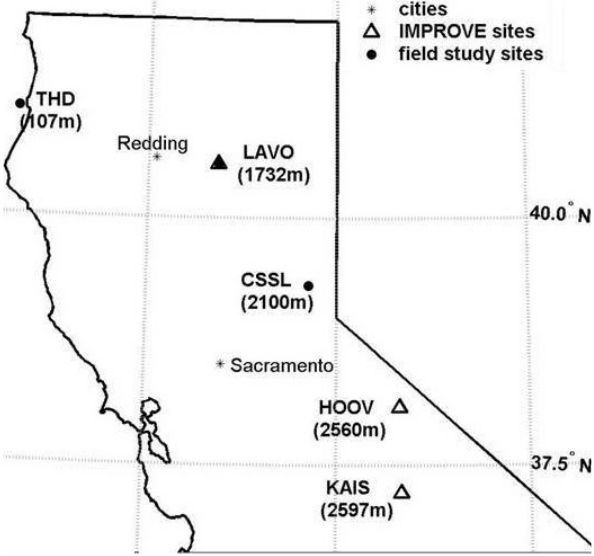
Fig. 1. Field study sites (circles) and IMPROVE sites (triangles) used in this study. LAVO is both an IMPROVE and field study site. The elevation is shown in